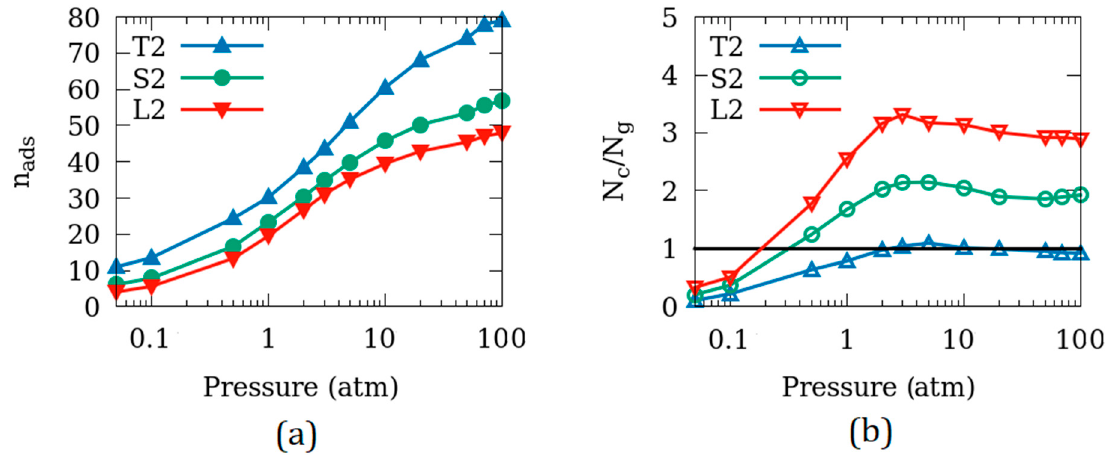
Figure 7. ( a ) Amount of CO 2 molecules adsorbed per unit cell of Mg-MOF-74; ( b ) N c / N g ratio of the CO 2 molecules adsorbed in crystallites of different sizes.